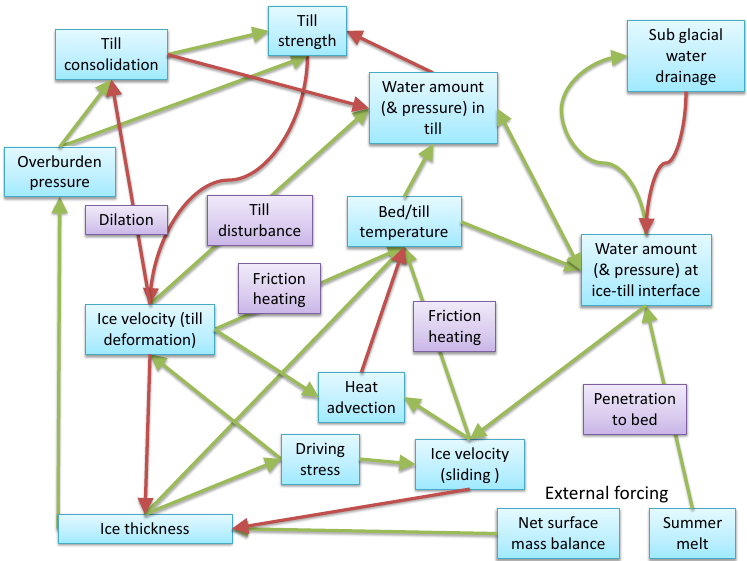
Figure 10. Properties (blue boxes) and processes (purple boxes) at the bed, and potential relationships/feedbacks between them. Red arrows indicate a decrease in the target property and green arrows indicate an increase. So a closed loop of arrows with an odd number of red arrows indicates a negative feedback, whereas a closed loop with an even number of (or zero) red arrows indicates a positive feedback. Note the “dilation” process could change to compression depending on the state of the till, changing the sign of the